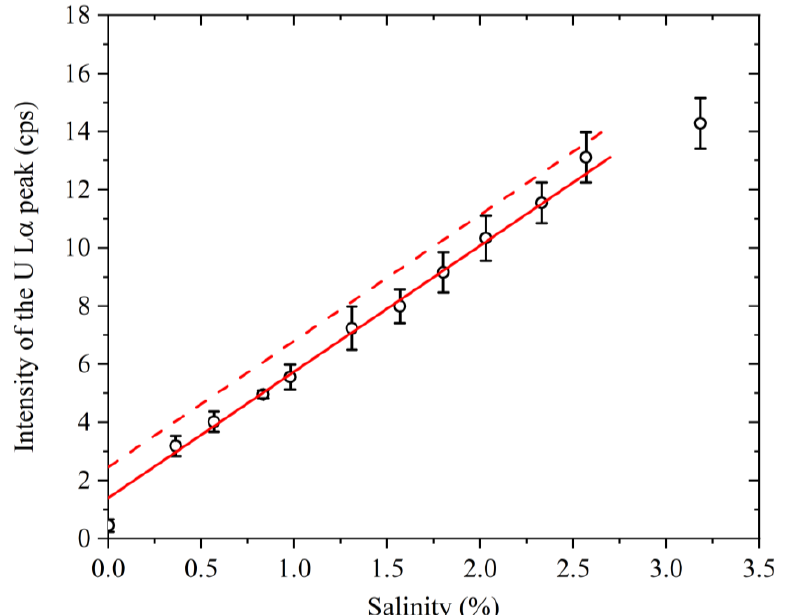
Figure 6. Relationship between the salinity and intensity of the U Lα peak. The error bars represent the standard deviations of the results obtained from six samples. The solid line is the result of linear fitting of the data set with a salinity range of 0.57 – 2.57%. The dotted line is the result of a vertical shift by an amount of signal intensity (1.1 cps) corresponding to the detection limit (DL).